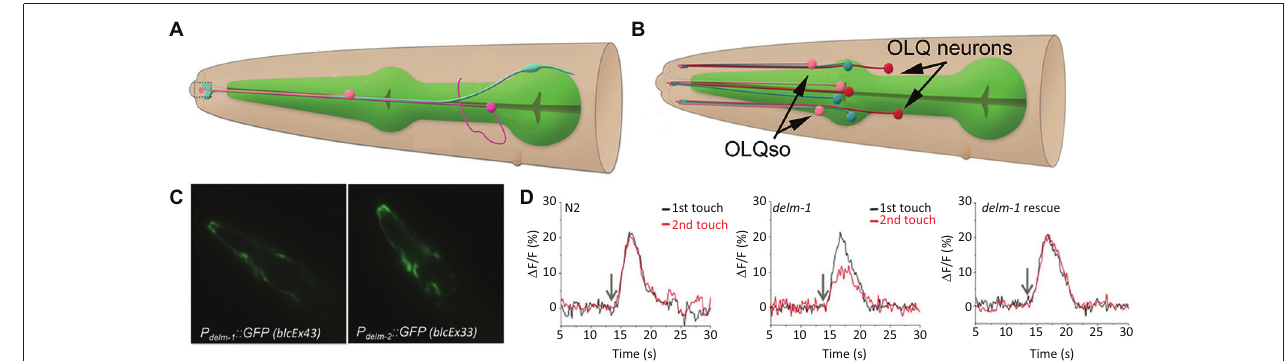
sensilla is not shown here; adapted from wormatlas.org . (C) The promoters for the delm-1 and delm-2 drive reporter GFP expression in the outer and inner labial sensilla socket glial cells (OLQso and ILso, respectively) of worms (strains blcEx43 and blcEx33, respectively). (D) Knock out of delm-1 leads to reduced OLQ neuron calcium response to mechanical stimulation of the worm (middle), while re-expression of the channel in OLQso glia (using the glial promoter itx-1 ) rescued the neuronal responsiveness (right); N2, background strain (left). C and D adapted from Han et al.